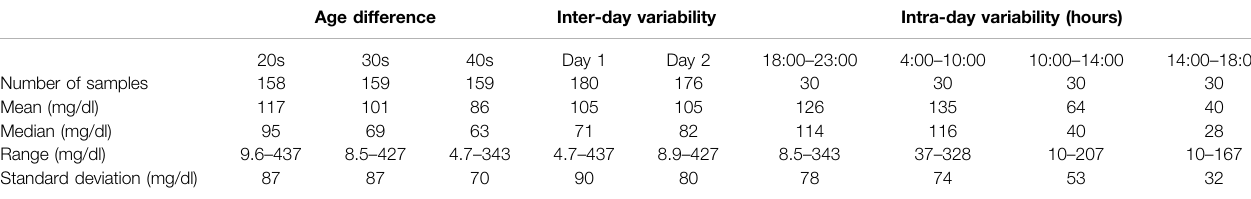
TABLE 3 | Creatinine concentrations in urine samples.